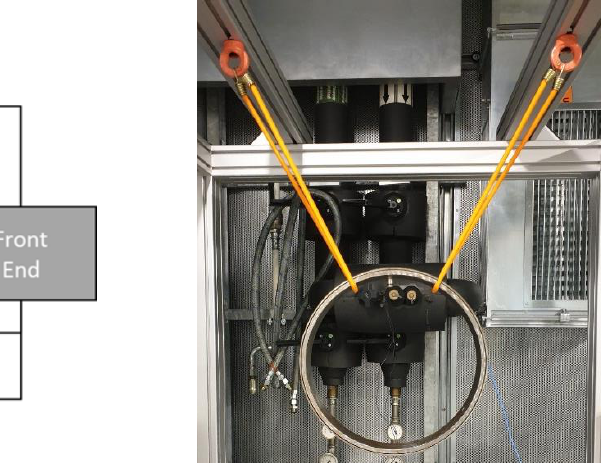
Figure 3. Measurement chain of the measurements of the freely suspended test setup ( left ) and the freely suspended test setup ( right ).